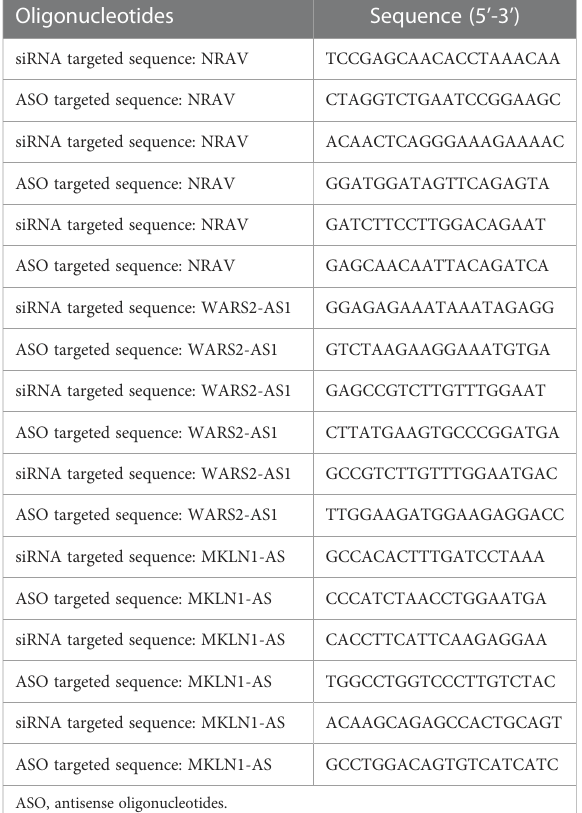
TABLE 1 Sequences of lncRNA smart